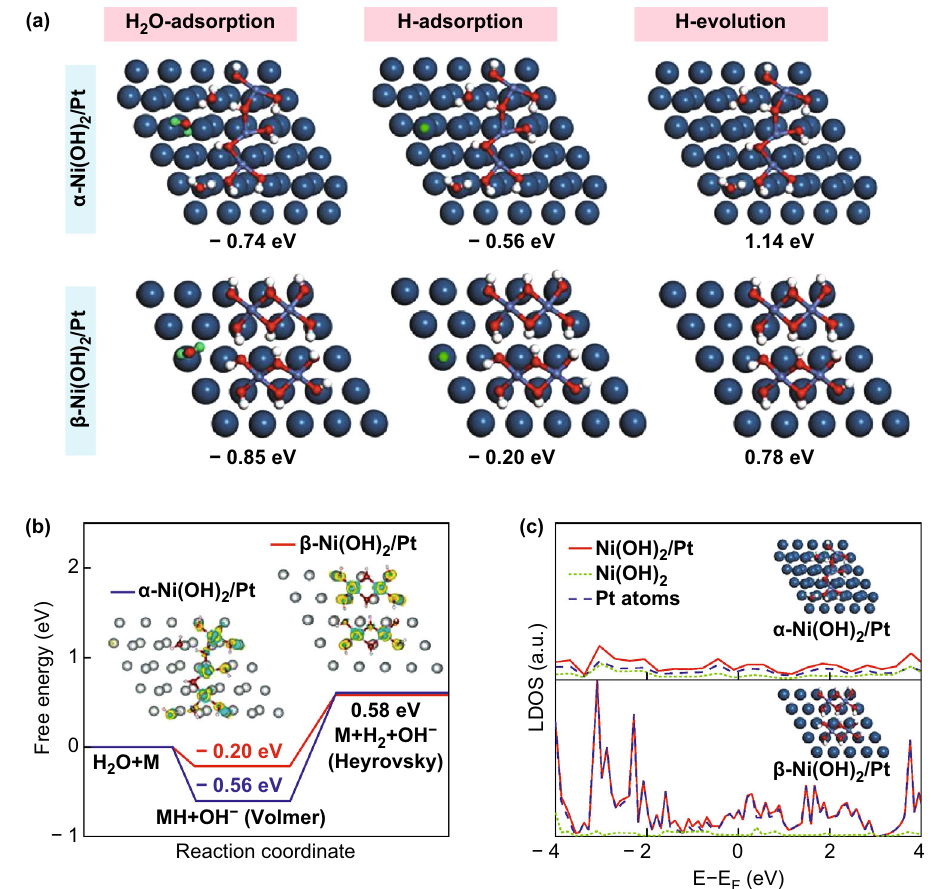
Fig. 5 a Free energies of H 2 O adsorption, H adsorption, and H 2 evolution on a - or b -Ni(OH) 2 /Pt electrode; for clarity, the adsorbed H atoms for the H 2 O molecules in the top site on the Pt surfaces are colored green. b Adsorption free energy diagram for the Volmer and Heyrovsky steps. c LDOS of the a - or b -Ni(OH) 2 /Pt electrode. Reproduced with permission of the authors of Ref. [53]. Copyright 2018, American Chemical Society. (Color figure